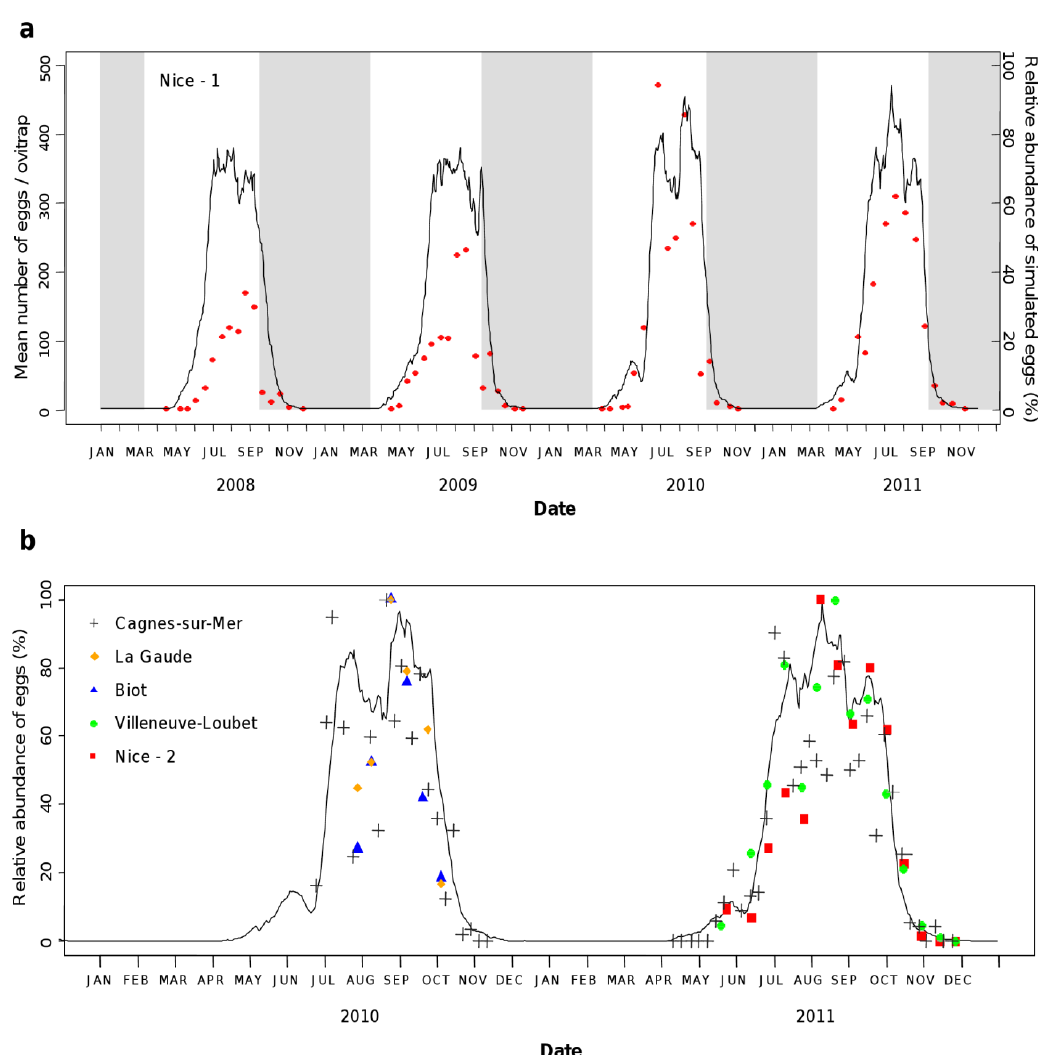
Figure 4. Model validation. ( a ) The simulated dynamics of eggs laid at time t E (black line) based on observed temperatures and precipitations from 2008 to 2011 was compared to the mean number of eggs collected per ovitrap in Nice-city area (red dots) using relative abundances. The alternation of favorable and unfavorable periods is represented in white and grey, respectively. ( b ) Simulated and observed eggs abundances, Nice area, 2010–2011. Symbols represent the observed mosquito abundance data in the different sites, and the black line is the simulated mosquito